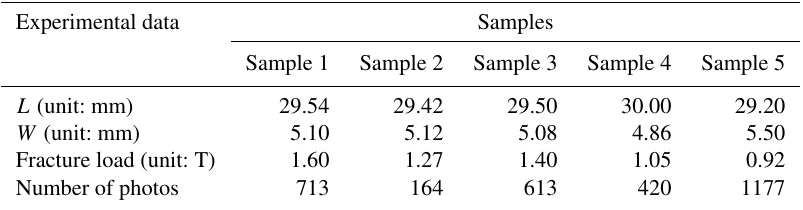
Figure 2. Schematic diagram of the sample and experimental device. Three-dimensional shape of the sample. (a) The deep black lines indicate the prefabricated cracks. L is the length of the upper surface, while W is the width of it. The directions of three-dimensional coordinates are shown in the lower left corner. (b) Two-dimensional shape of the sample. (c) Two-dimensional shape of the sample. The area enclosed by the dash-line rectangle is the observational domain, and the solid-line rectangle is the computational domain. The red dots space 5 pixels apart from each other are the sampling points in the computational domain. (d) Experimental loading mode and observational and computational domain of the sample. There are random artificial speckle signals on the sample. The arrow indicates the direction of loading, and the two blue lines show the precast cracks. The gray zone represents the observational domain, and the area enclosed by the rectangle is the computational domain. Table 1. The detailed data of the five